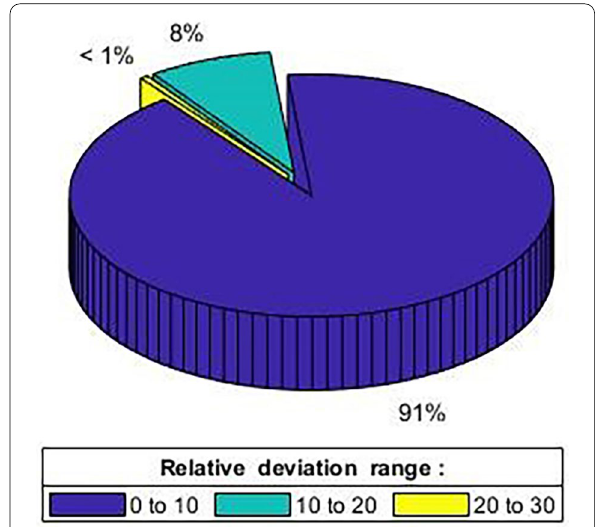
Fig. 8 Proportion of predicted values of the GRA–SVR model within relative deviations